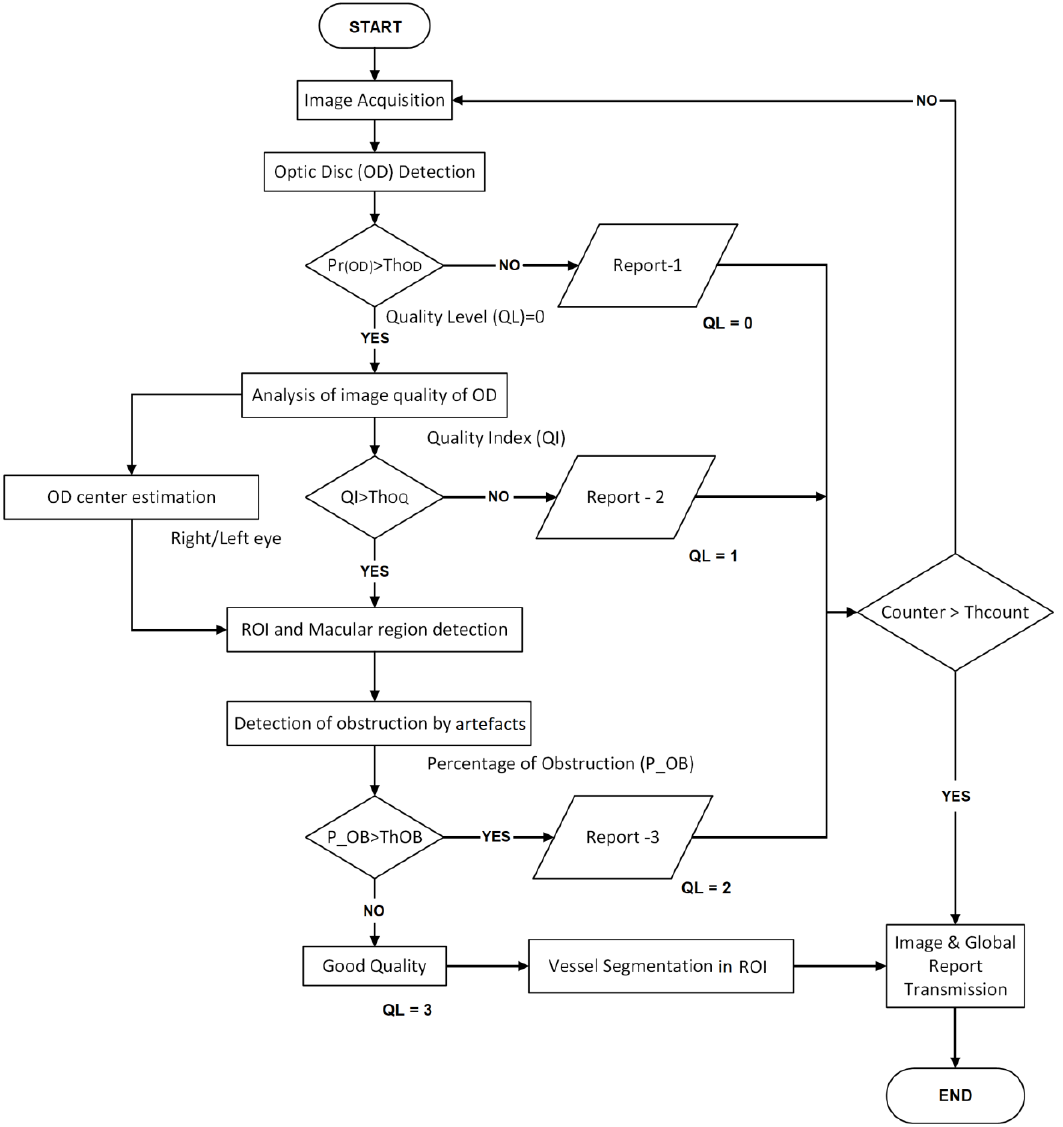
Figure 2. Block diagram of the proposed teleophthalmology support system.